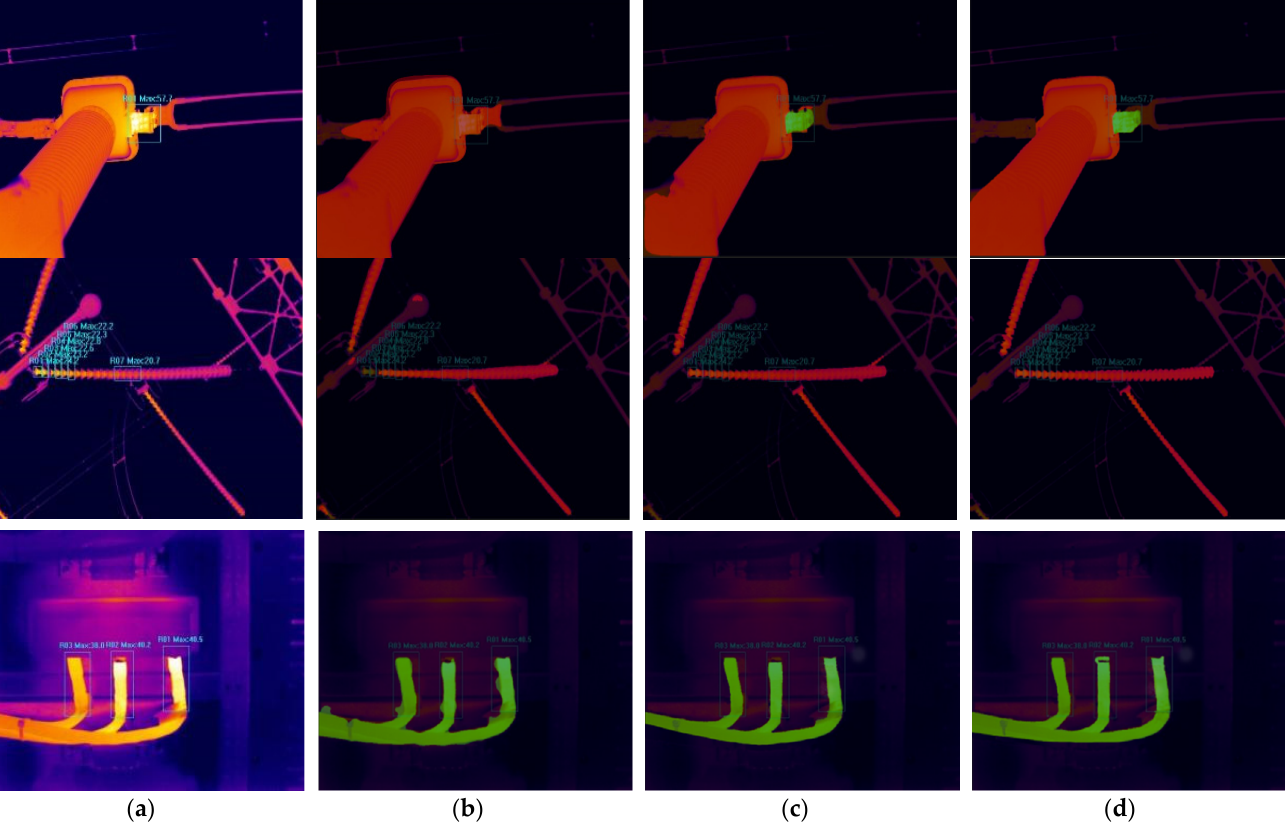
Figure 9. Network prediction effect diagram: ( a ) original drawing; ( b ) U-Net; ( c ) Deeplabv3+; and ( d ) CS_Deeplabv3+.